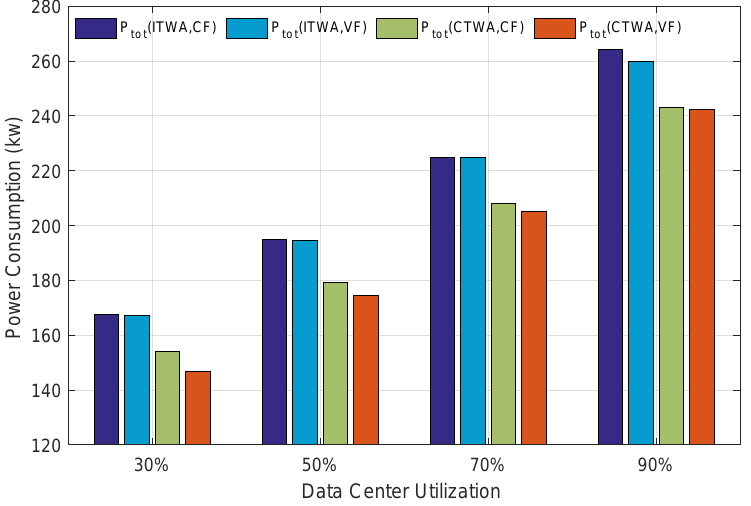
Figure 13. Total power consumption of data center for the case